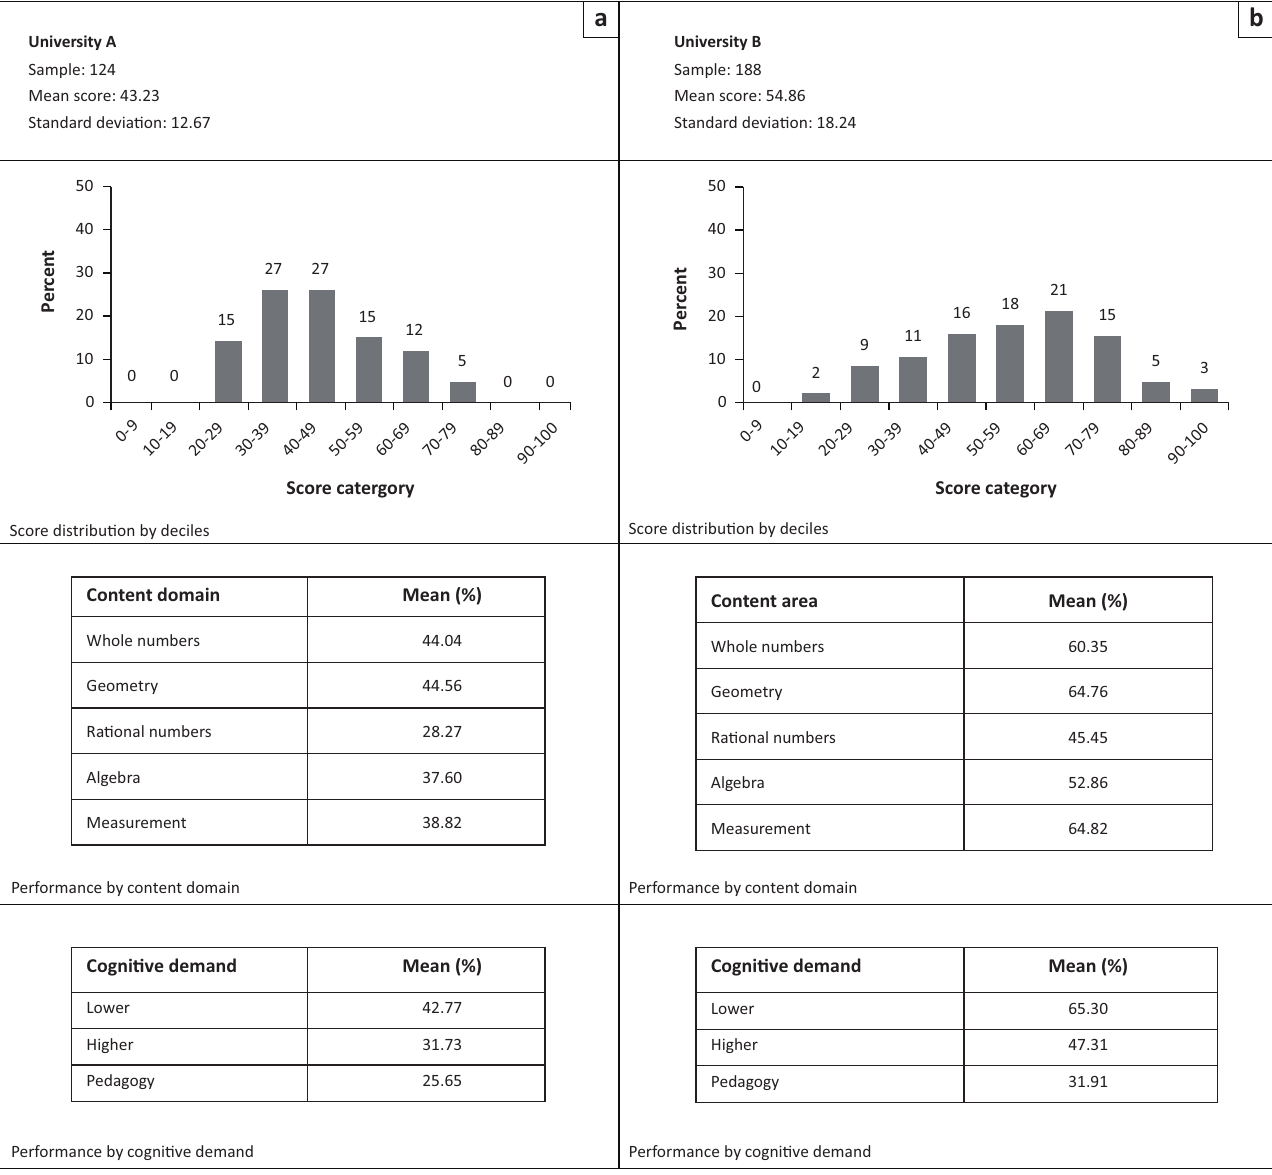
FIGURE 6: (a) First-year student 2018 performance for University A; (b) First-year student 2018 performance for University